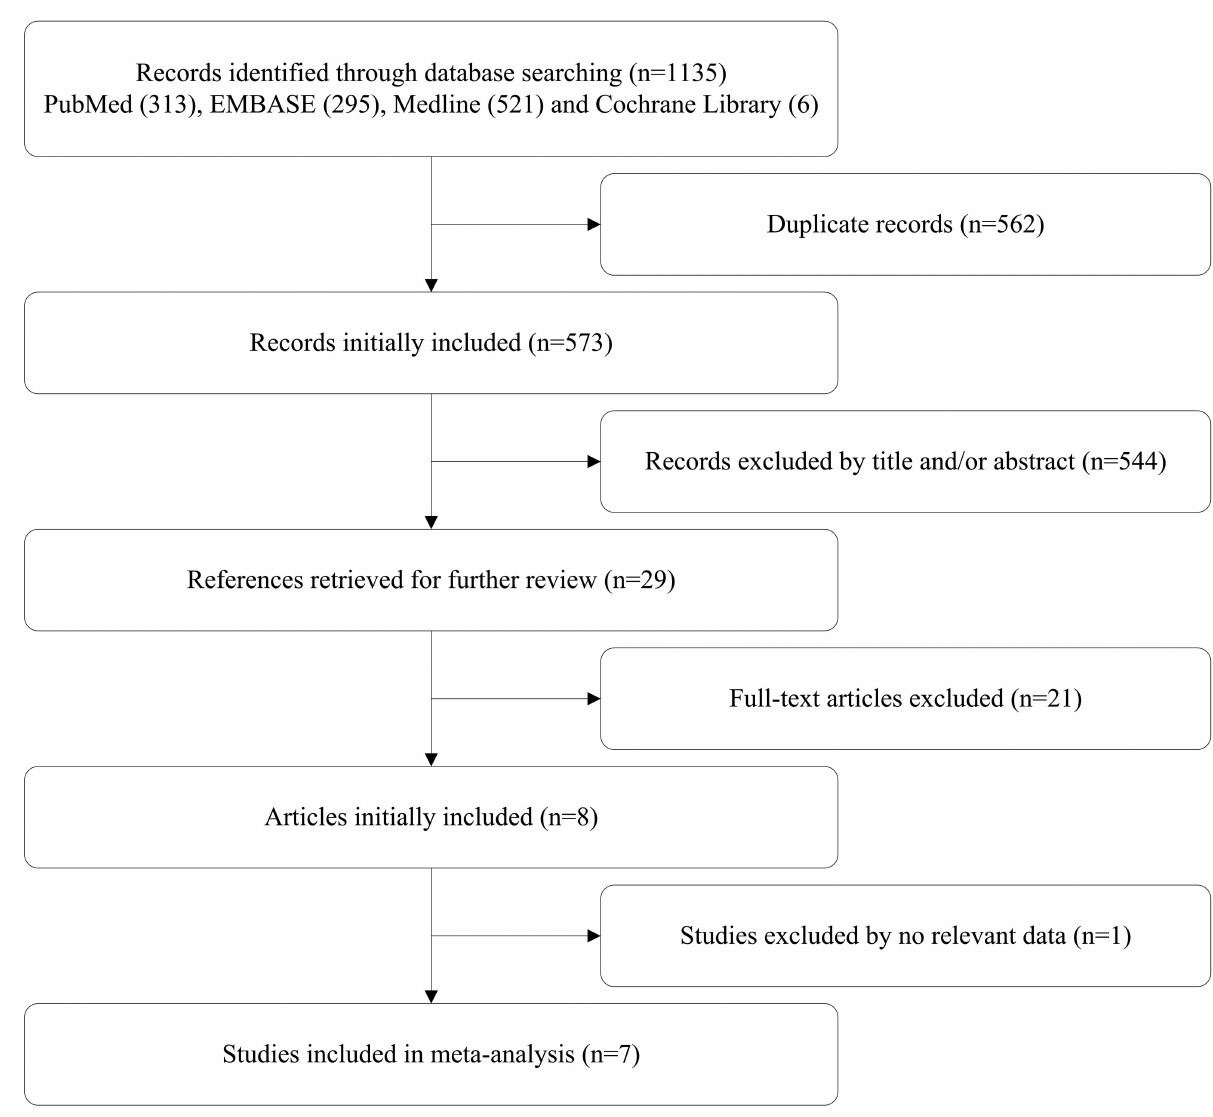
Figure 1 - Flow chart of the literature search and article